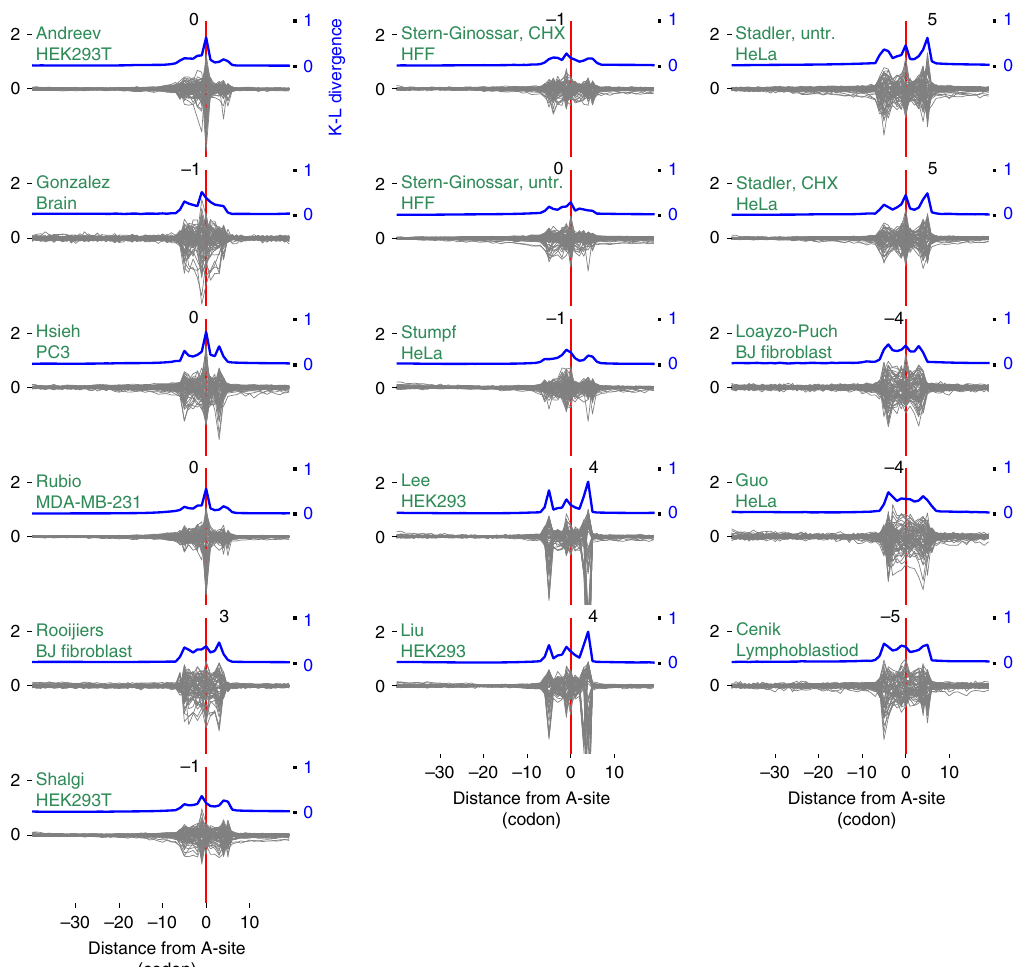
Figure 3 | RUST metafootprint profiles of the 16 human ribo-seq data sets. Data sets are indexed by the name of the first author followed by drug treatment and source, see Table 1 for more details. The Kullback–Leibler (K–L) divergence is shown in blue, the coordinates of K–L maximum are indicated above the peak in each plot. Zero coordinate corresponds to the inferred position of the A-site and is marked with a red line, coordinates are in codons. See Supplementary Fig. 4 for non-human